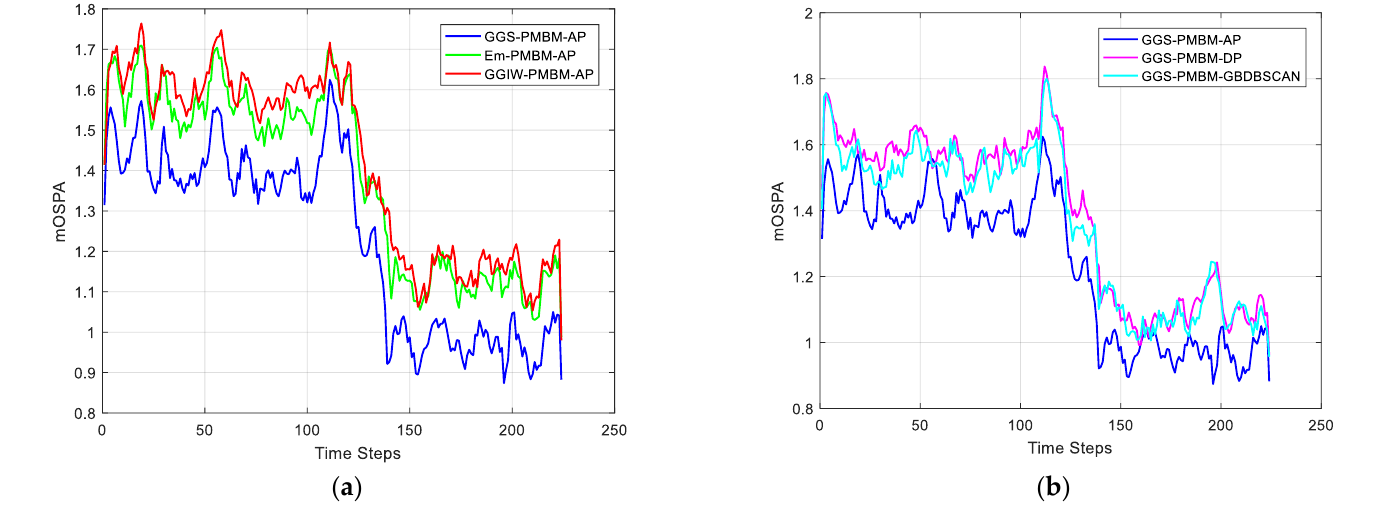
Figure 11. Averaged mOSPA. ( a ) the performance of different tracking algorithm based on the same measurement partition method; ( b ) the performance of different measurement partition methods based on the same tracking algorithm.